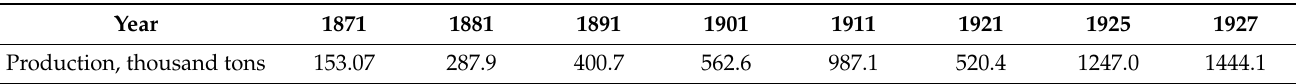
Table 1. The volume of global zinc production in the years 1871–1927, worked based on [17].